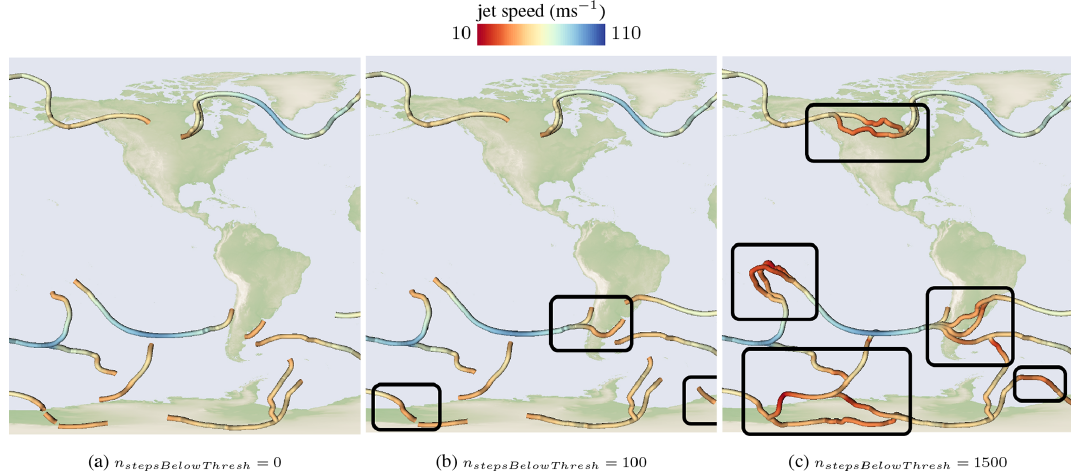
Figure 5. Increasing the number of prediction steps, a jet core might remain below the wind magnitude threshold, resulting in longer connected jet core lines. The data here are for 11 September 2016 at 15:00UTC.